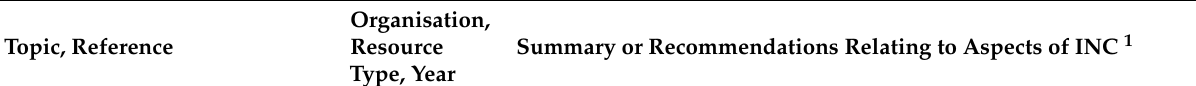
Table 2. Individualised nutritional care in nutrition